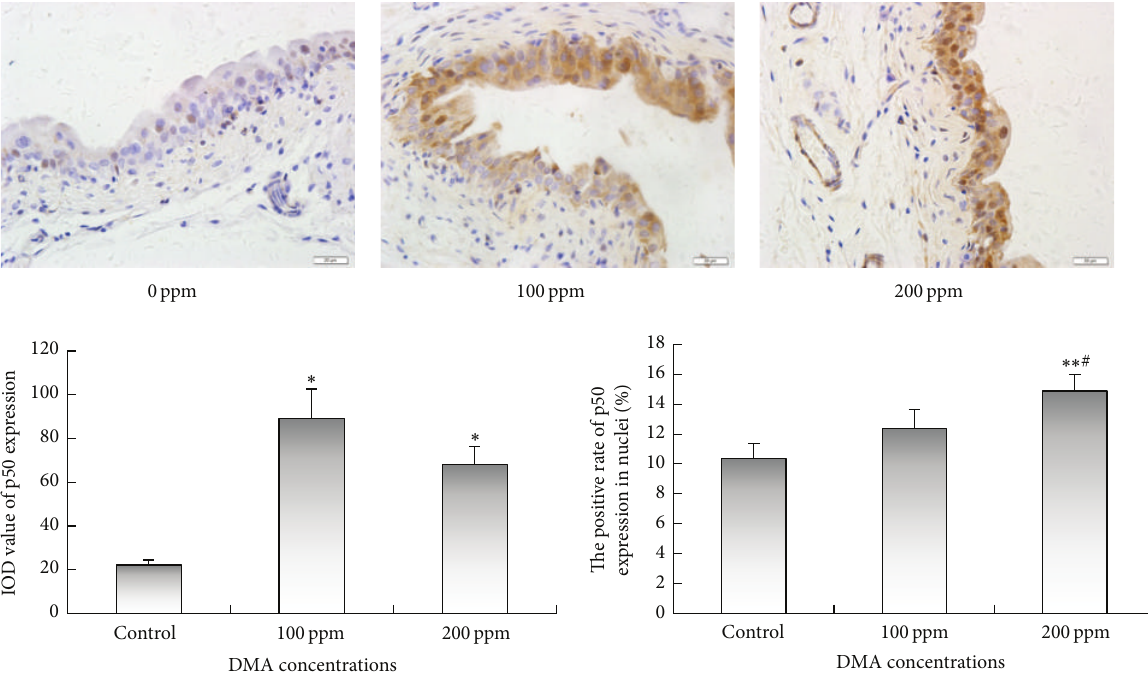
Figure 5: p50 immunohistochemical staining of bladder epithelium in DMA V treated rats. p50 expressions were presented in brown in cytoplasm and nucleus. The panel was a graphical representation of the immunohistochemical staining of p50. Bars were presented as mean ± SD. ∗ 𝑝 < 0.05 and ∗∗ 𝑝 < 0.01 compared to the control group. # 𝑝 < 0.05 compared to 100ppm DMA V treated